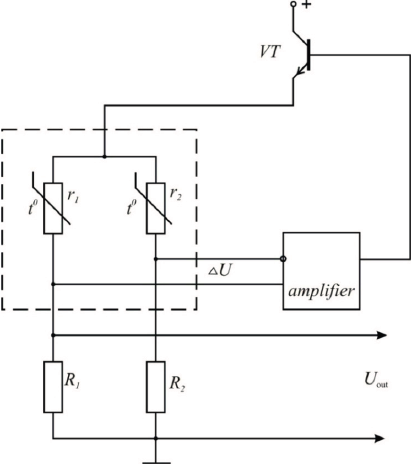
Figure 6. The thermo-anemometer electric circuit.